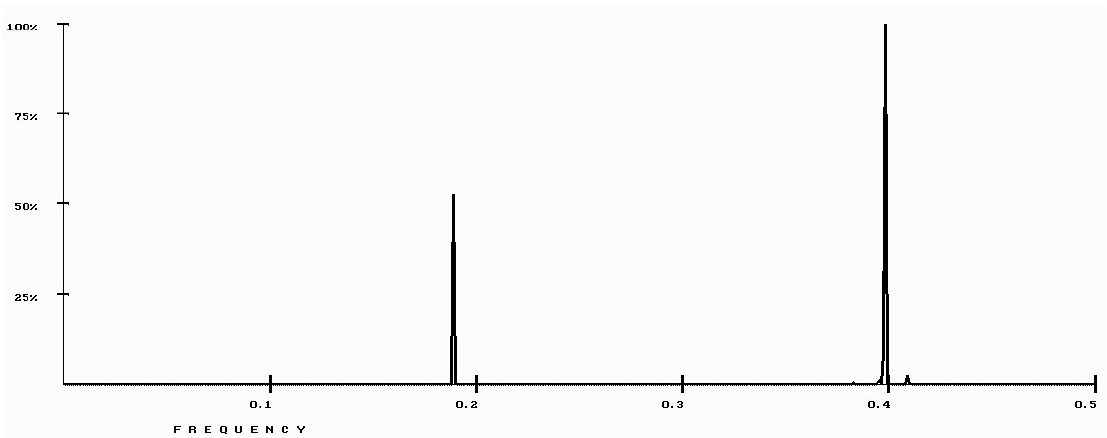
Figure 8. RRM cross-spectrum of parathyroid hormone proteins, parathyroid hormone receptor1 proteins and SDF-1 α proteins. The more prominent common characteristic frequency for these proteins is at f3 = 0.3975 ± 0.0108, which represents an electromagnetic radiation wavelength of about 502 nm, while the less prominent frequency is at f2 = 0.1885 ± 0.0108, which represents an electromagnetic radiation wavelength of about 1066 nm.